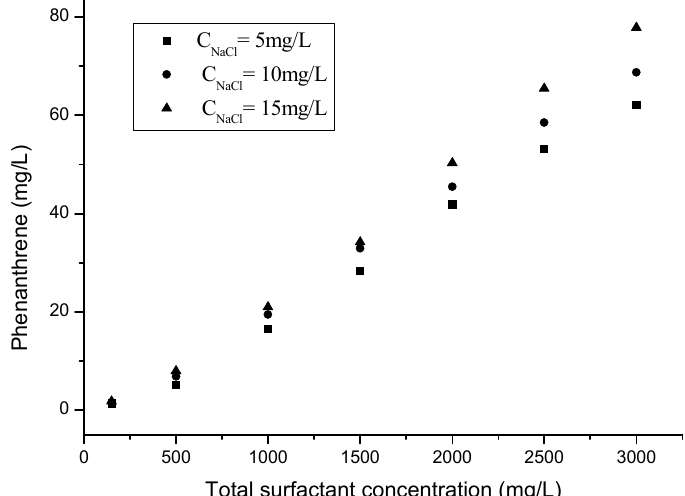
Figure4. SolubilizationofphenanthrenewithcoexistingNaCl(5,10,and15mg / L)intheTX100–rhamnolipids mixture at CMC, 500, 1000, 1500, 2000, 2500 and 3000 mg / L (the mass ratio between TX100 and Figure 4. Solubilization of phenanthrene with coexisting NaCl (5, 10, and 15 mg/L) in the TX100– rhamnolipids was 3:1, and C NaCl is the concentration of rhamnolipids mixture at CMC, 500, 1000, 1500, 2000, 2500 and 3000 mg/L (the mass ratio between TX100 and rhamnolipids was 3:1, and C NaCl is the concentration of NaCl).